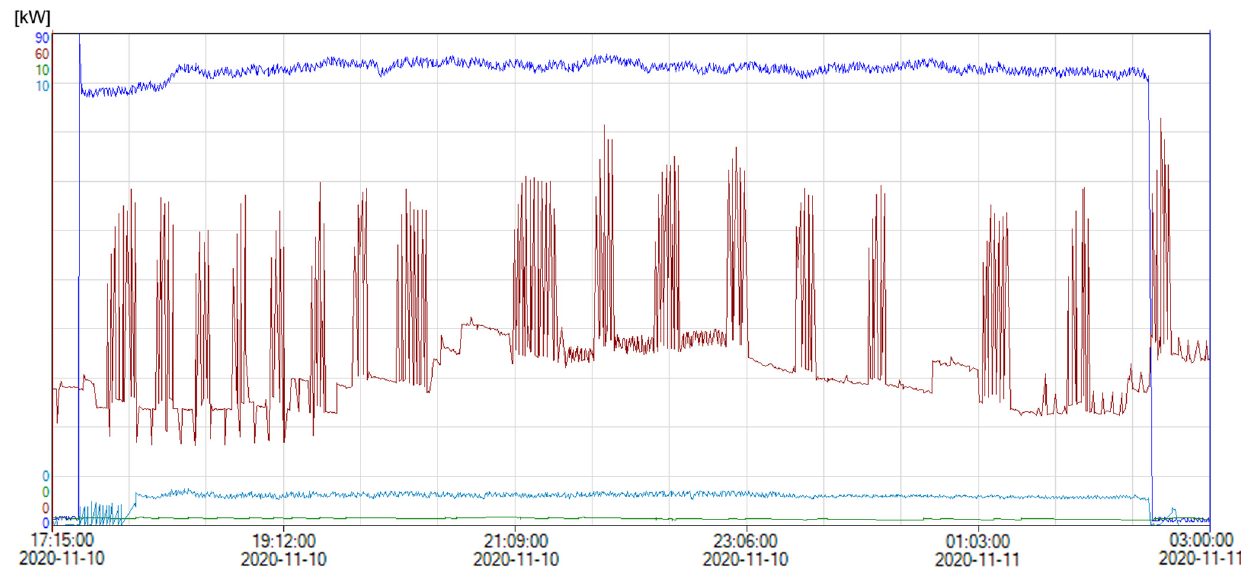
Figure 1. Example of energy consumption for broccoli production, process ID 373. The colors of the stages are: S1—brown, S2—green, S3—dark blue, S4—light blue.